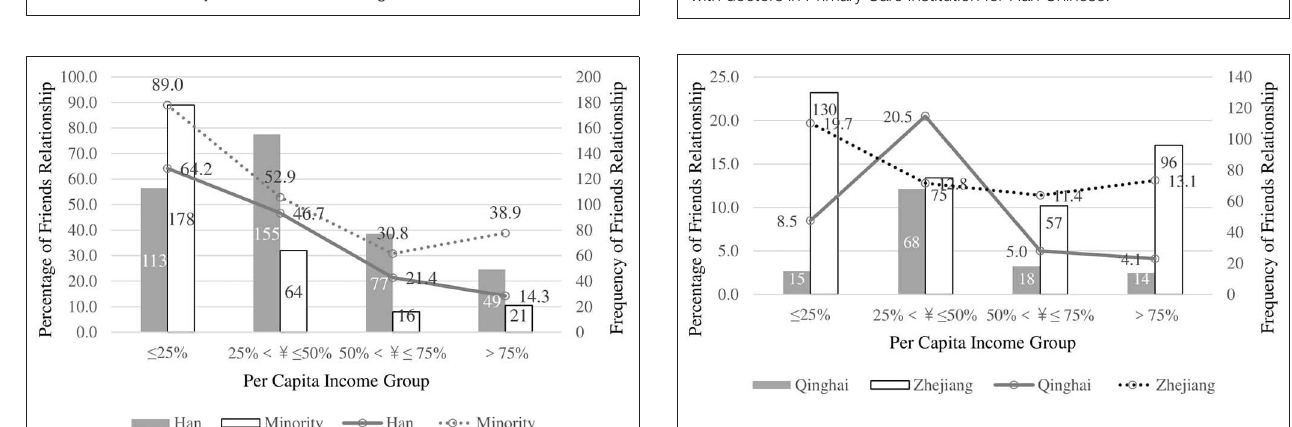
FIGURE 4 | Interaction between ethnics and income for Friends relationship with doctors in Big Hospitals for Han